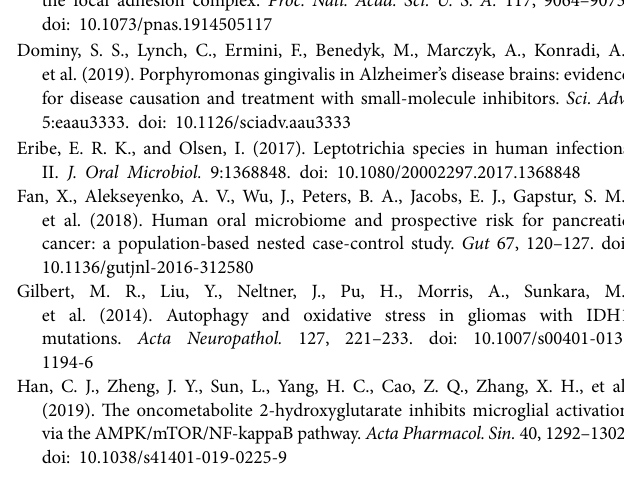
Supplementary Figure 1 | Study flow-chart. A total of 59 participants from the cross-sectional study (HCs = 24, LGG = 12, HGG = 24) with 16S oral microbiome profiling were included in the study. *1 patient with LGG was pathologically diagnosed with non-glioma. **1 patient with HGG was not received surgery. Abbreviations: HCs, healthy controls; LG, low glioma group; HGG, high- grade glioma. Supplementary Figure 2 | Bacteria taxonomic profiling at the phylum level of oral microbiome from healthy controls and glioma patients. Box plots show the relative abundance of Firmicutes, Bacteroidetes, Proteobacteria, Actinobacteria, Fusobacteria, and Spirochaetota in HCs, LGG, and HCG. Each box plot represents the median, interquartile range, minimum, and maximum values. The p value was calculated by non-parametric Mann-Whitney U test. Value of p < 0.05 indicated the statistical significance. HCs, healthy controls; HGG: high-grade glioma; LGG: low-grade glioma. Supplementary Figure 3 | Relative abundance of different bacteria genus in healthy and glioma patients. Bacteria taxonomic profiling at the genus level of oral microbiome from healthy controls and glioma patients. (A) The 18 bacteria at the genus level in the oral microbiome, “Others” represents the bacteria with the relative abundance of less than 1%. (B) The proportion of Streptococcus, Prevotella, Porphyromonas, Veillonella, Haemophilus, Actinomyces, Neisseria, Porphyromonas, and Granulicatella among HGG and HC groups at the genus level; (C) the box plots show the relative abundance of Leptotrichiaceae in HCs, LGG, and HGG. Each box plot represents the median, interquartile range, minimum, and maximum values. The p value was calculated by non-parametric Mann-Whitney U test. p value <0.05 indicated the statistical significance. HCs, healthy controls; LGG: low-grade glioma; HGG: high-grade glioma. Supplementary Figure 4 | Microbial functions altered in the IDH1-mutant group and IDH1-wild-type group. Heat map showing the medial abundance of all significant modules as determined by PICRUSt analysis at IDH1-mutant group and IDH1-wild-type group. Notes: * p < 0.05, ** p < 0.01, *** p < 0.001. Abbreviations: PICRUSt, Phylogenetic Investigation of Communities by Reconstruction of Unobserved States; HCs, healthy controls; HGG, high-grade glioma. PICRUSt, Phylogenetic Investigation of Communities by Reconstruction of Unobserved States; IDH1, isocitrate dehydrogenase 1; HCs, healthy controls; HGG: high-grade